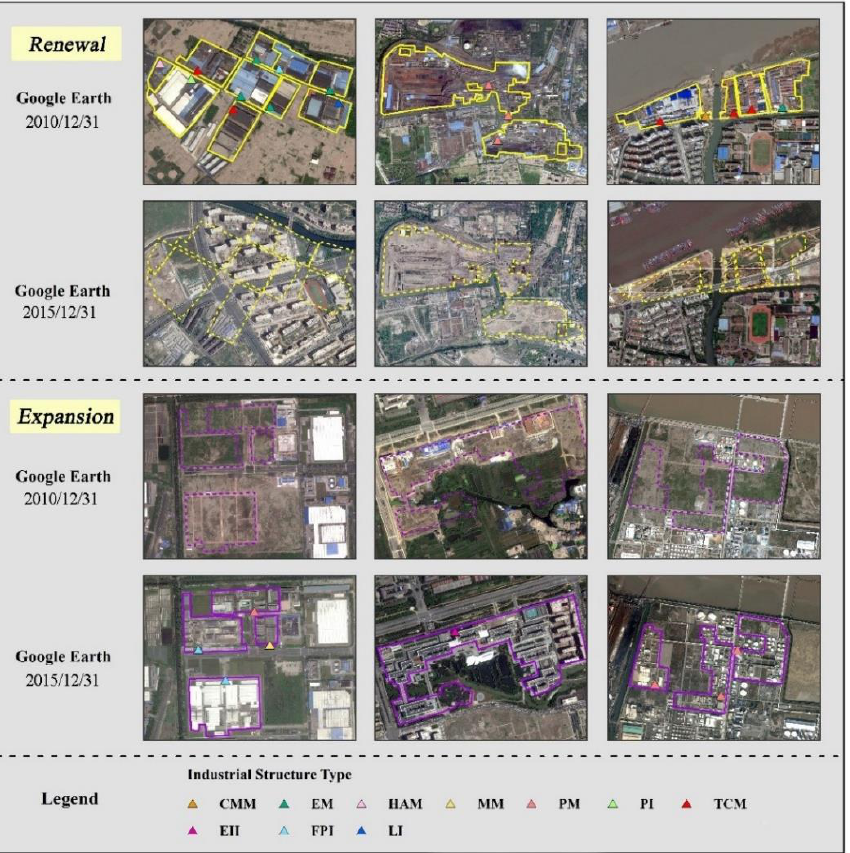
Figure 5. Visual examples of industrial changes (renewal or expansion) in GE images during 2010 – 2015.